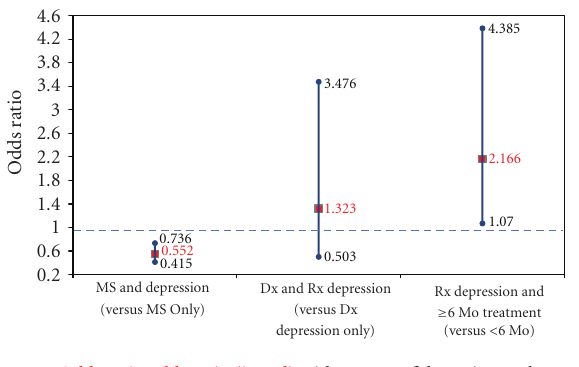
Odds ratio odds ratio (in red) with 95% confidence intervals Patients with MS and depression, compared to those with MS only, were 44.8% (100-0.552) less likely to achieve a MPR threshold of at least 80% with their MS medication. Patients with comorbid depression who were treated with an antidepressant for at least 6 months, compared to those treated with an antidepressant for < 6 months, were 116.6% (2.16–1) more likely to achieve an MPR threshold of at Least 80%. Figure 2: Impact of depression on probability of achieving MPR threshold of